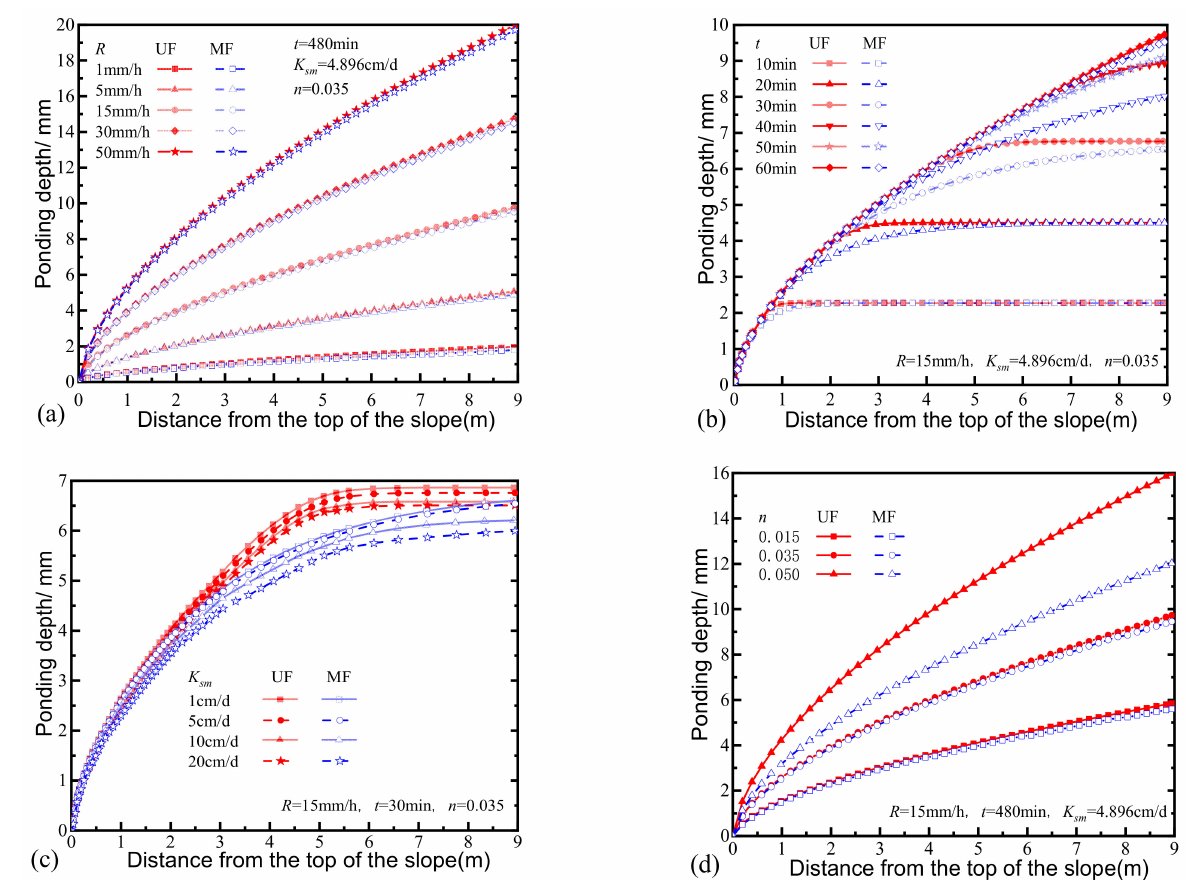
Figure 11. The influence of different factors on ponding depth: ( a ) Rainfall intensity, R ; ( b ) Rainfall duration, t ; ( c ) Saturated conductivity, K sm ; ( d ) Roughness coefficient, n